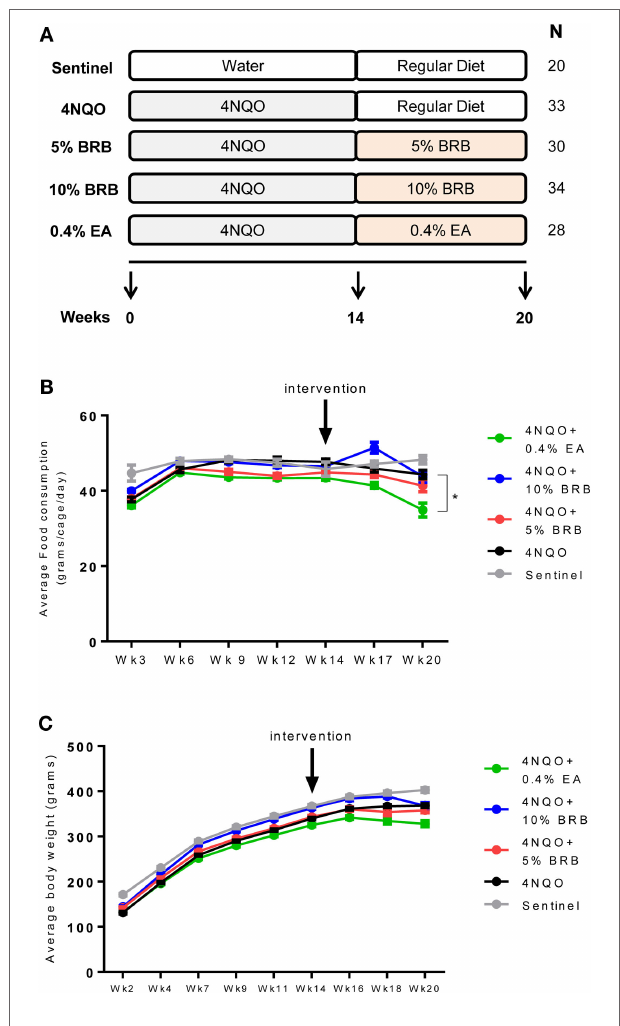
FigUre 1 | (a) Scheme of rat oral carcinogenesis and chemoprevention. Rats were exposed to oral carcinogen 4-nitroquinoline 1-oxide (4NQO) (20 μ g/ml in drinking water) for 14 weeks. Administration of dietary chemopreventive agent began at week 14 and continued for 6 weeks. Animals were sacrificed at week 20 for gross and histological analysis of tongue lesions and examination of cellular and molecular markers of carcinogenesis. N represents number of rats per group. (B) Average food consumption for the control and experimental rat groups during oral carcinogenesis and dietary intervention phases of the experimental protocol. Data are expressed as mean food consumption (grams/cage/day) ± SE in each rat cage belonging to an experimental group (three rats per cage). * p -value < 0.05 for food intake comparison between 4NQO-only rat group and 4NQO + ellagic acid (EA) rat group using independent Student’s t -test. (c) Average body weight measurements for control and experimental rat groups during the carcinogenesis and intervention phases of the experimental protocol. With the exception of the sentinel animals, all experimental animals were administered 4NQO and were on AIN-76A defined diet prior to intervention with dietary black raspberries (BRBs) or EA. Data are expressed as mean ± SE of all rats in the